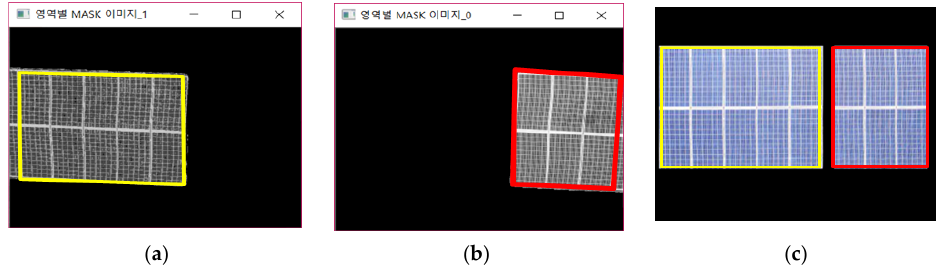
Figure 12. Process of obtaining a rectified image: ( a ) sub-block MB 1; ( b ) sub-block MB 2; ( c ) rectified block RB 1 , RB 2.